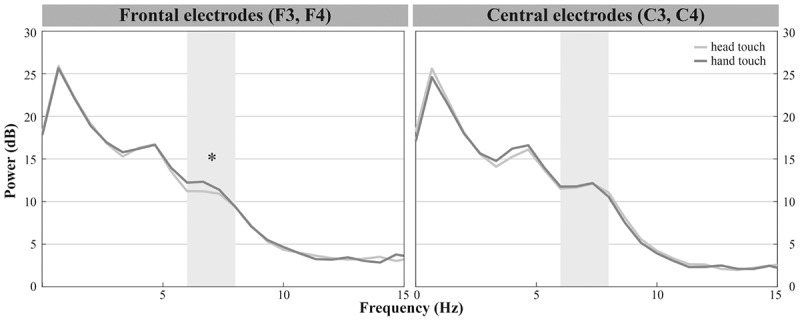
Grand average EEG mu power for hand touch (dark gray) and head touch (light gray) for an average of frontal electrodes (F3, F4) and for an average of central electrodes (C3, C4) in the hands-free condition. Asterisks depict significant differences with p < 0.05.